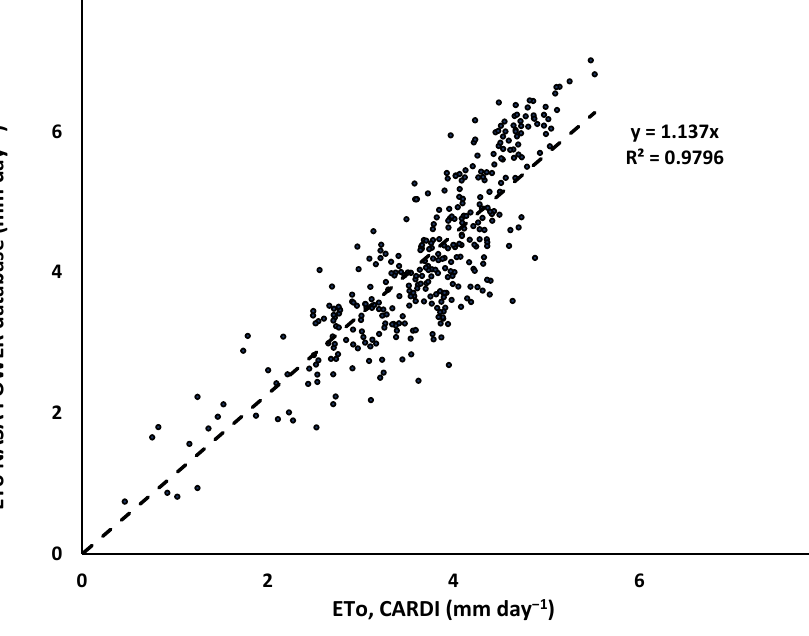
Figure 1. Relationship between ET o calculated from weather data measured at CARDI and estimated from corresponding NASA POWER weather data.